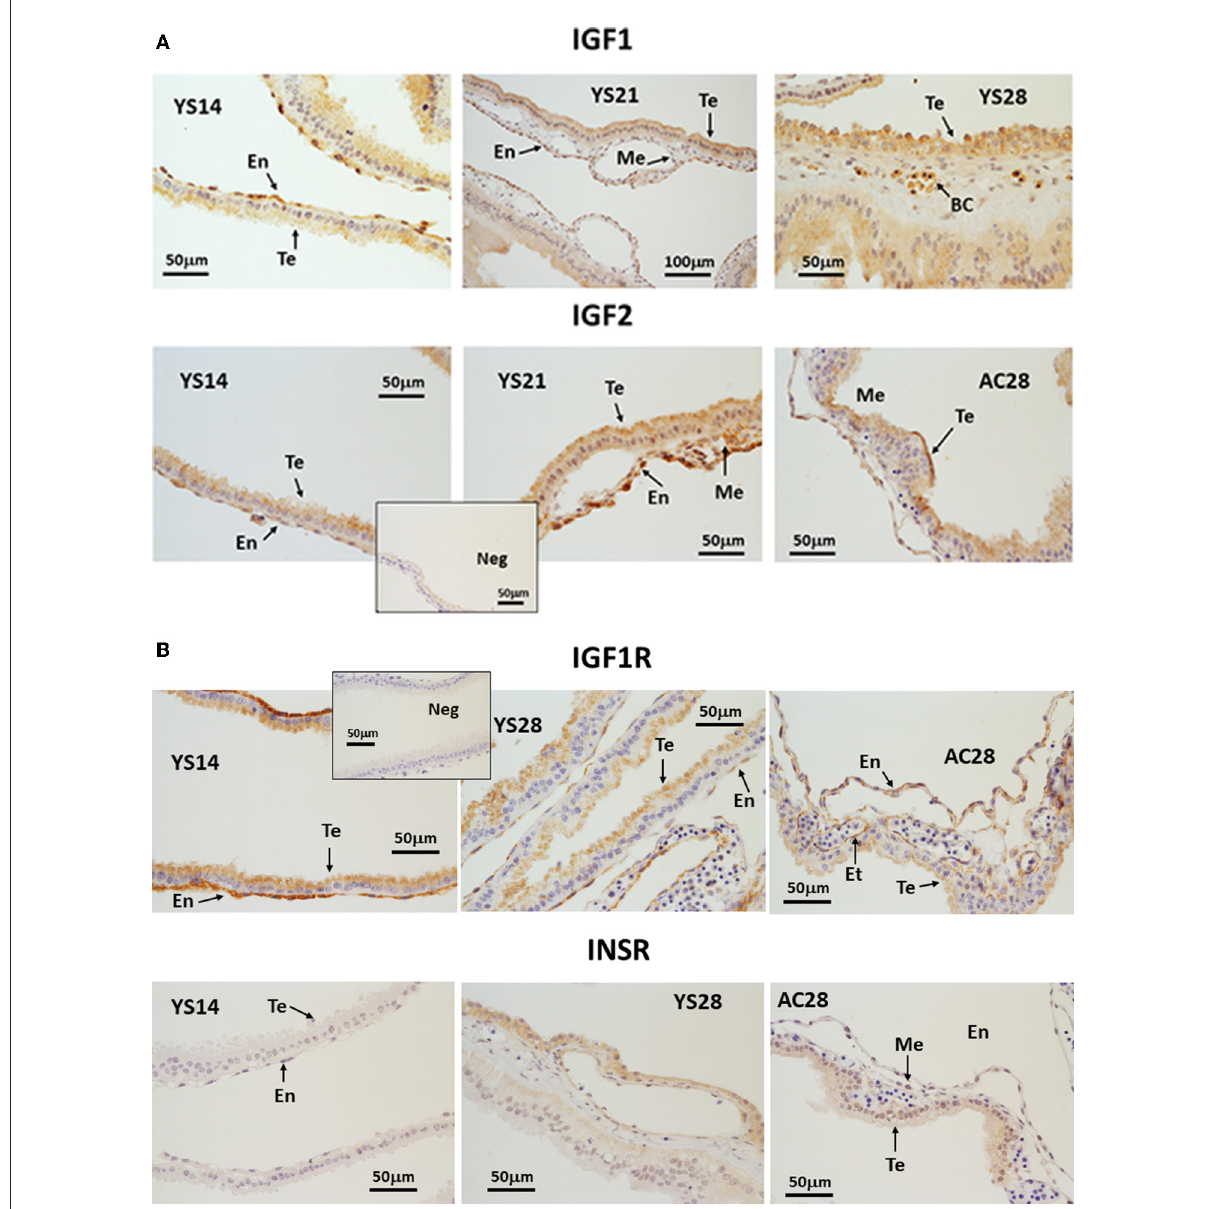
FIGURE4 (A, B) Immunohistochemical localization of (A) IGF1 and IGF2, (B) IGF1R and INSR in equine conceptus membranes on days 14, 21 and 28 of pregnancy (YS, yolk sac; AC, allantochorion). Te, trophectoderm; En, endoderm; Me, mesoderm; BC, blood cells; Et,